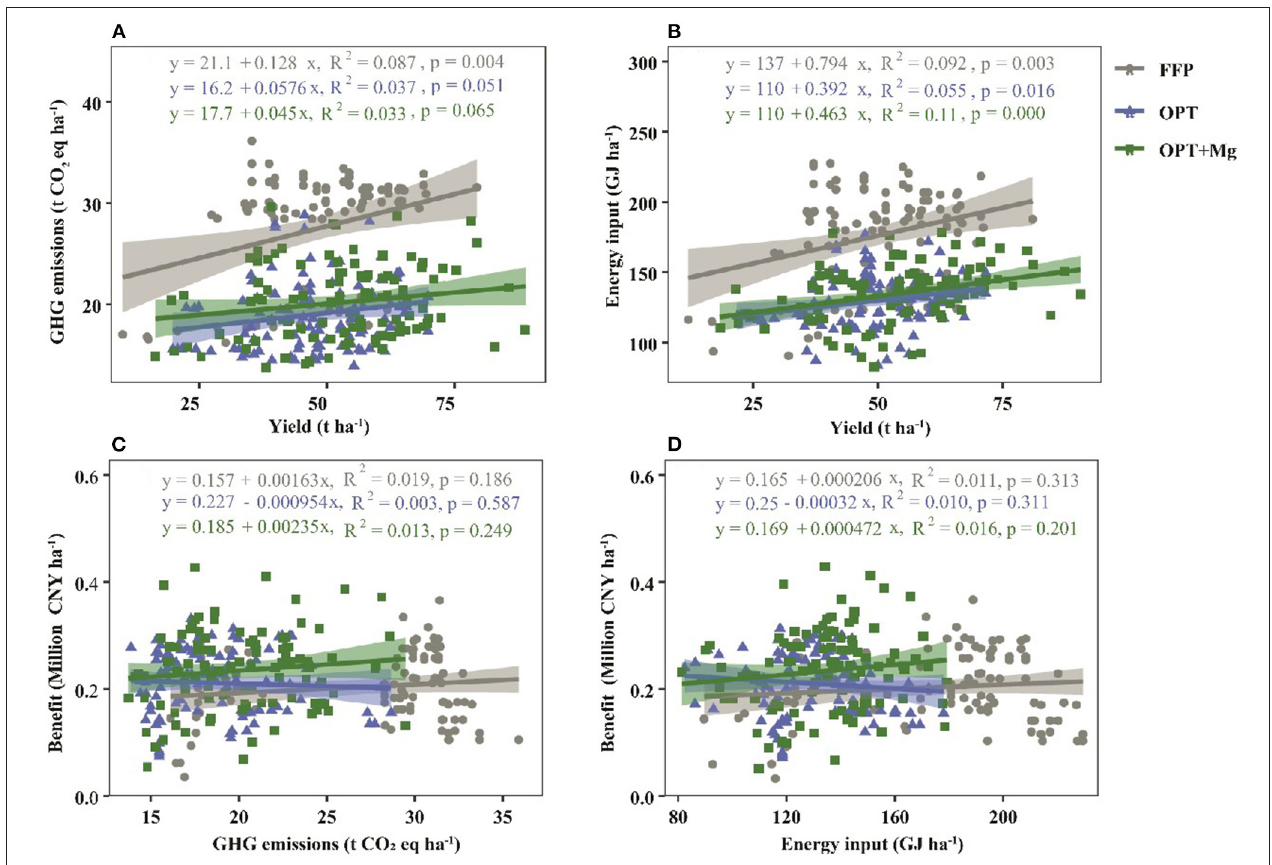
FIGURE 7 | Linear relationship between yield and GHG emissions (A) , yield and energy input (B) , GHG emissions and benefit (C) , energy input and benefit (D) . The different colors of the scattered dots, lines, shadows, and formulas represent the different fertilizer treatments. The shaded areas represent the 95% confidence intervals.